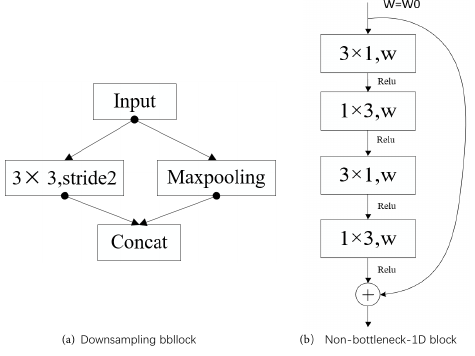
Figure 4. ( a ) The downsampling block. ( b ) The non-bottleneck-1D